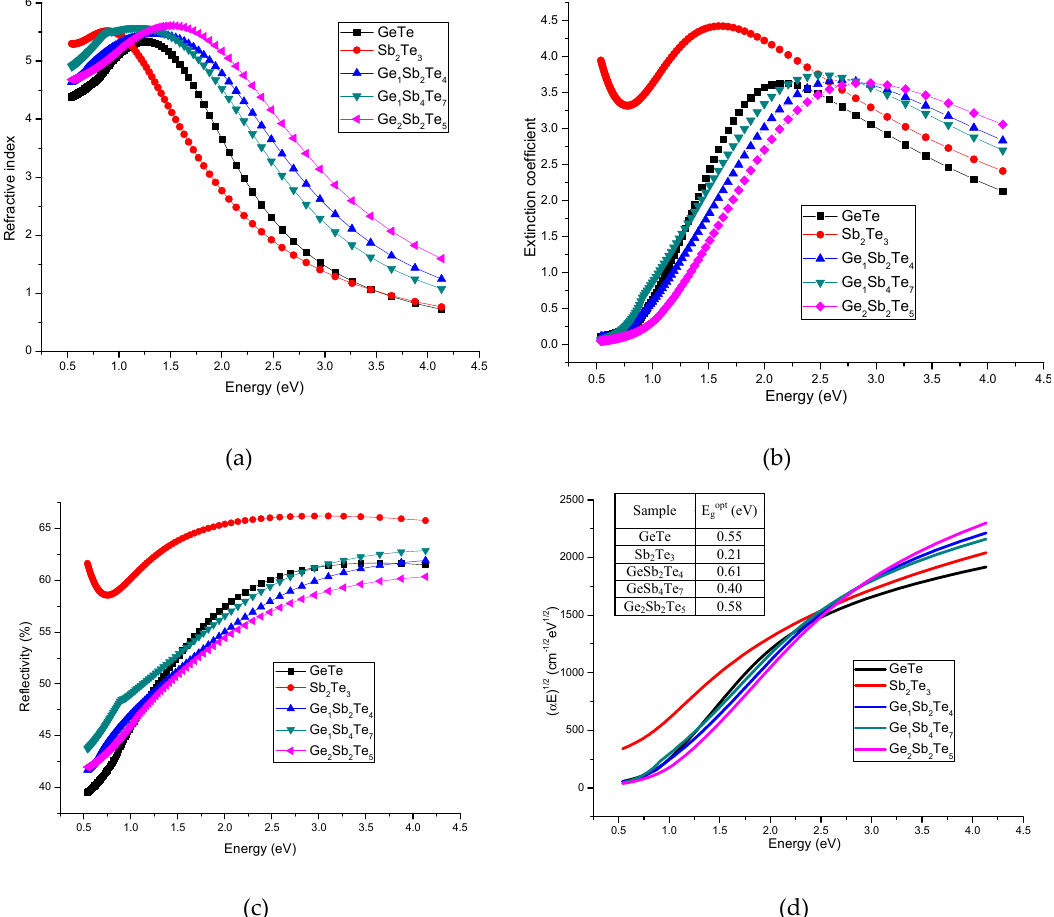
Figure 7. The ellipsometry results: the energy dependence of refractive index ( a ), extinction coefficient ( b ), reflectivity ( c ), and ( α E) 1/2 ( d ) for the Ge-Sb-Te based thin films deposited using the 266 nm radiation of the Nd-YAG laser.